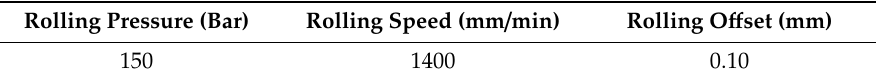
Figure 2. Schematic diagram of the friction stir welding (FSW) process. Table 4. The deep-rolling process